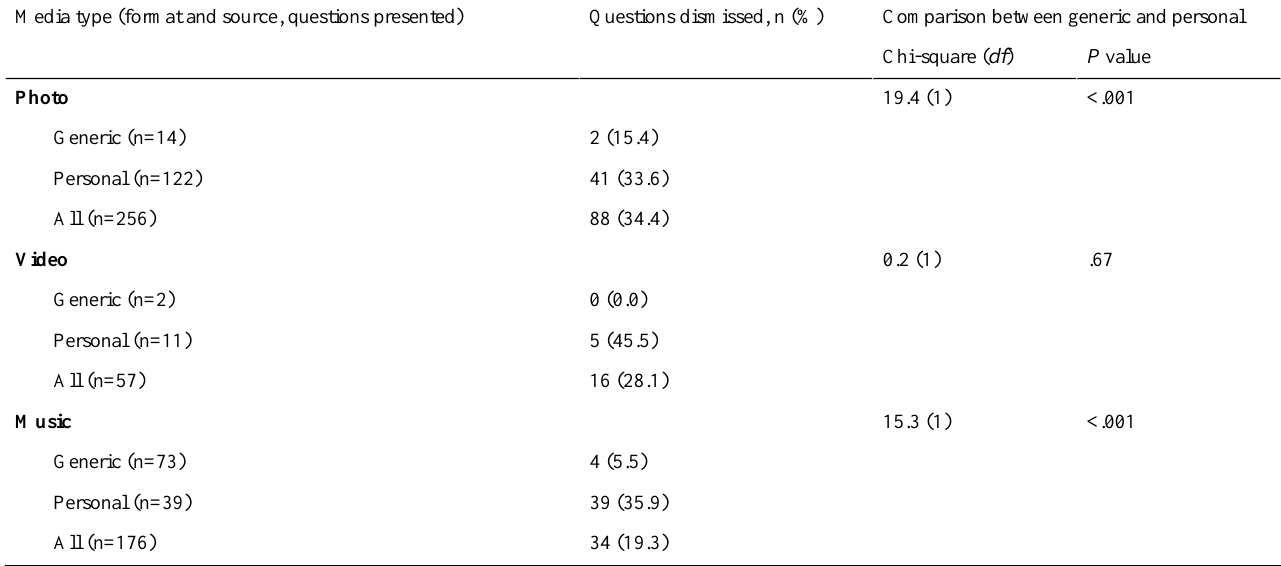
Table 3. Question presentation and dismissal following reminiscence with different